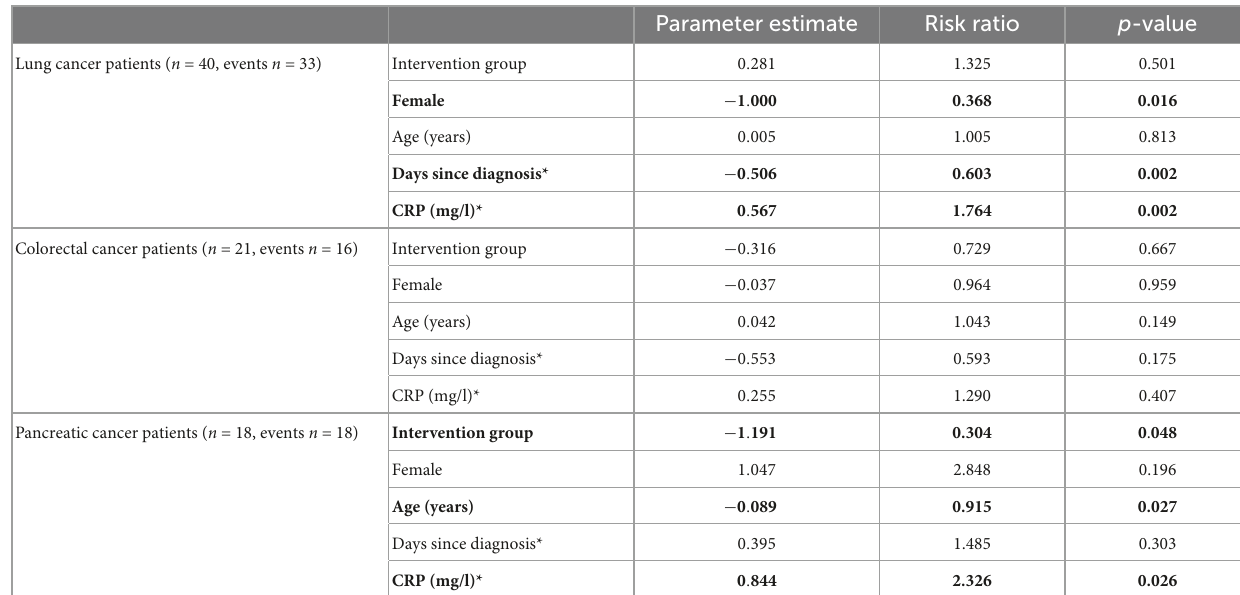
TABLE 4 Analysis of survival time for different tumor